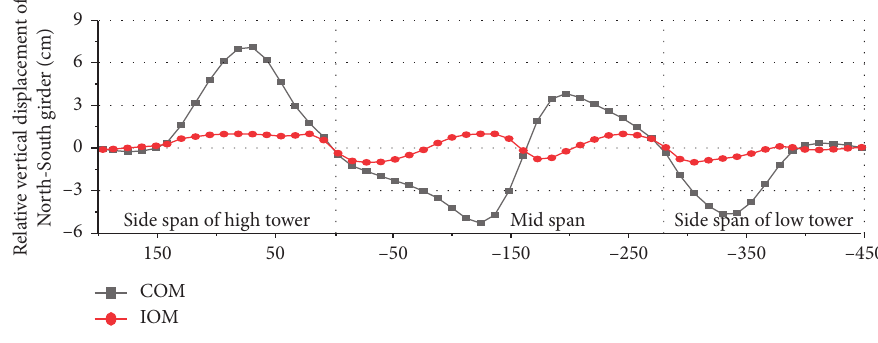
Figure 14: Comparison of torsion between main girders. Table 3: Comparison of maximum values of reasonable finished state between COM and IOM. Evaluation